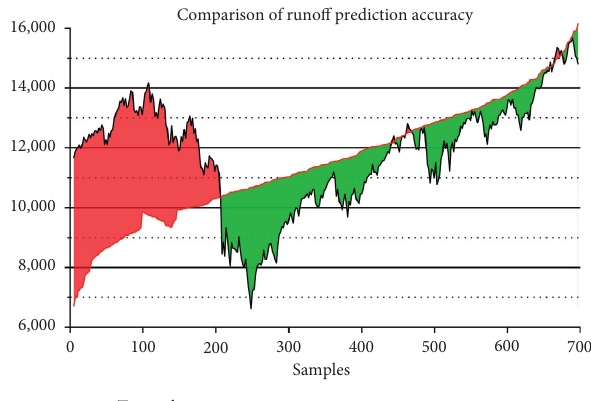
Figure 7: Comparison of runoff prediction